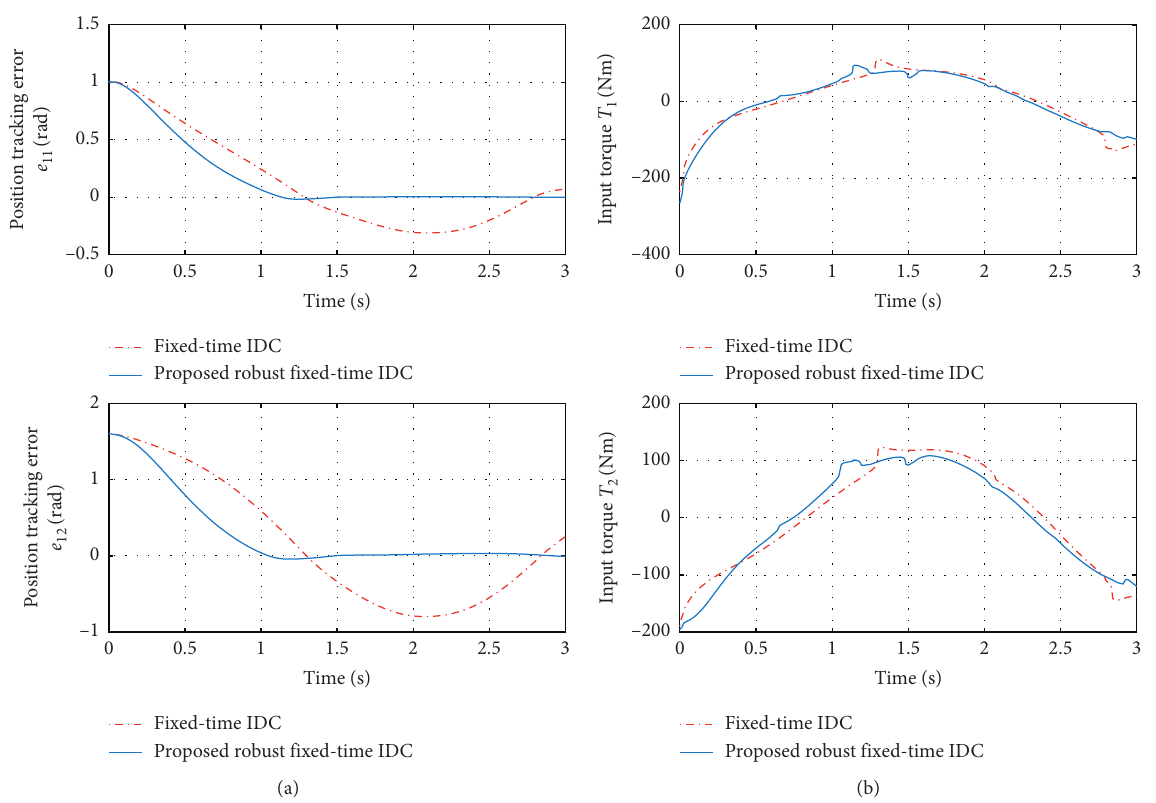
Figure 6: Responses in case 5. (a) Position tracking errors. (b) Input